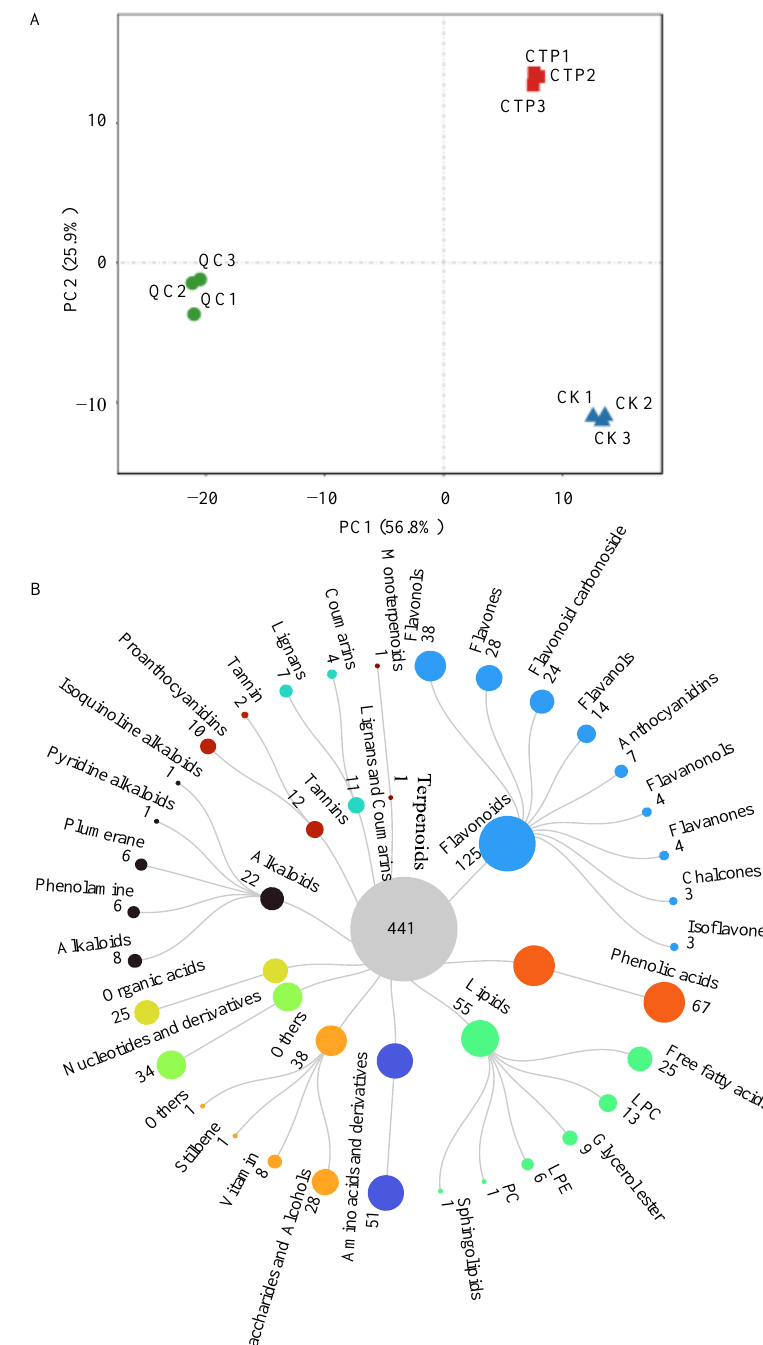
Figure 3. Results of the metabolomics analysis. PCA ( A ) and classification ( B ) of identified metabo- lites in CTP, CK, and QC. LPC: lysophosphatidylcholine, LPE: lysophosphatidylethanolamine, PC: phosphatidyl cholines.